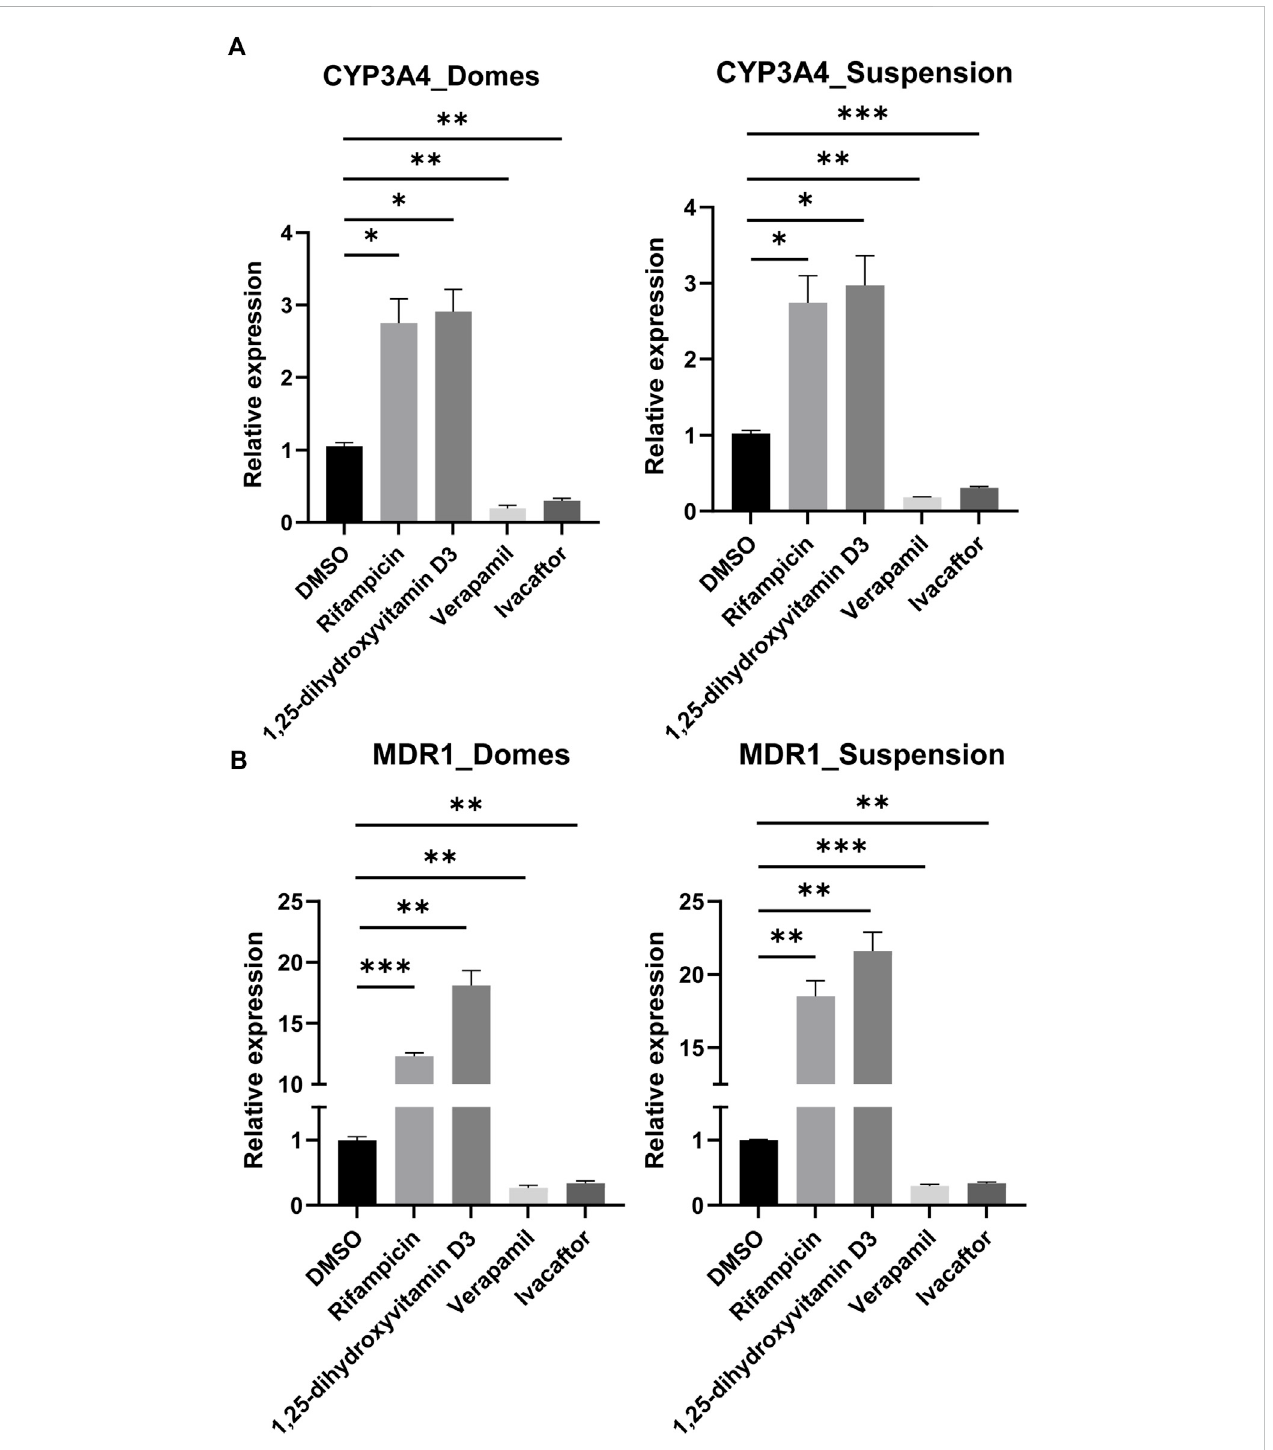
FIGURE 6 Induction and inhibition of CYP3A4 and MDR1 . (A, B) Assessment of CYP3A4 (A) and MDR1 (B) levels in organoids grown embedded in Matrigel domes and suspension, following drug treatment with the inducers rifampicin and 1,25-dihydroxyvitamin D3 and the inhibitors verapamil and ivacaftor for 48 h. In both organoid models, there are signi fi cant differences in the expression levels following treatments compared to DMSO-treated controls. Notably, the upregulation of MDR1 expressionfollowingtreatmentwithrifampicinand1,25-dihydroxyvitaminD3wasmorerobustintheapical-outorganoidsthanin the apical-in organoids. Error bars indicate mean ± S.E.M ( n =